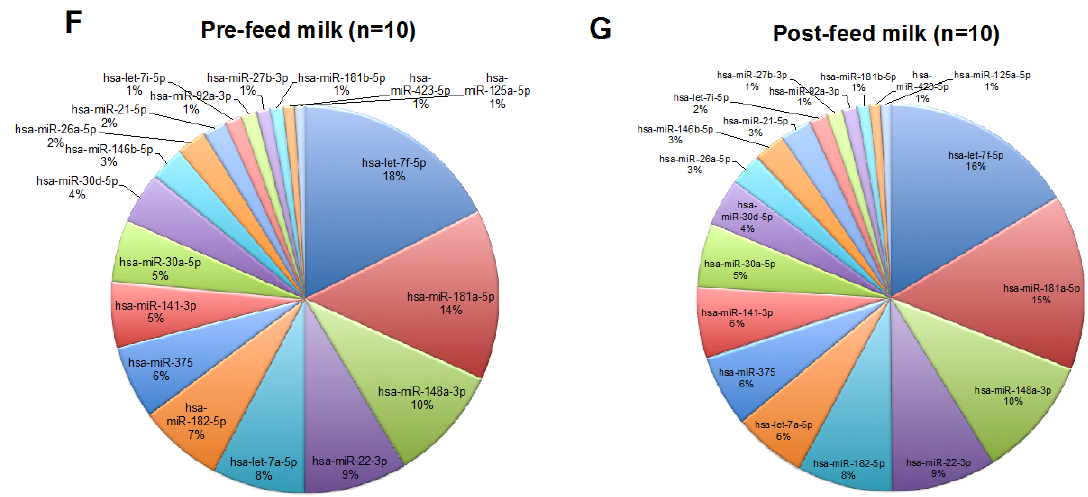
Figure 3. Comparison of HM cell content, total miRNA content, and profiled miRNA species between pre- and post-feed milk. ( A , B ) A positive association was found between the total miRNA content and the number of known miRNAs, using either NanoDrop or Bioanalyzer; ( C ) Positive relationship between total cell content per mL of HM and the number of known miRNA species; ( D , E ) Comparisons of total cell content per mL of HM and miRNA content (ng/10 6 ) between pre- and post-feed milk. The top 19 most highly expressed miRNA species were identical in pre-feed milk ( F ) and post-feed milk ( G ), and accounted for 86.2% of the total miRNAs in all samples ( n = 20).